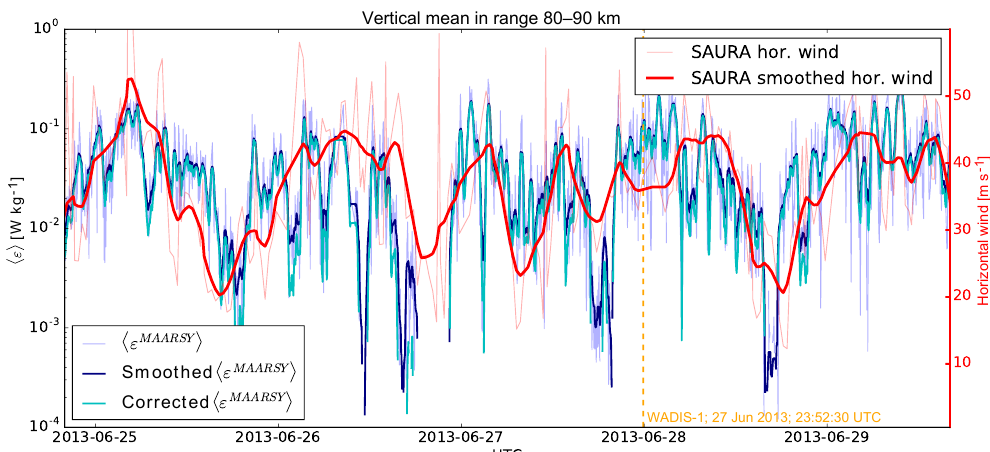
Figure 20. Vertical mean values over altitude range 80–90km. Thin semitransparent lines show full-resolution data, while bold lines show running mean values. Dark- and light-blue bold profiles show (cid:104) ε (cid:105) values for MAARSY before and after applying correction for horizontal wind, respectively. Red lines and the right y axis show SAURA measurements of horizontal